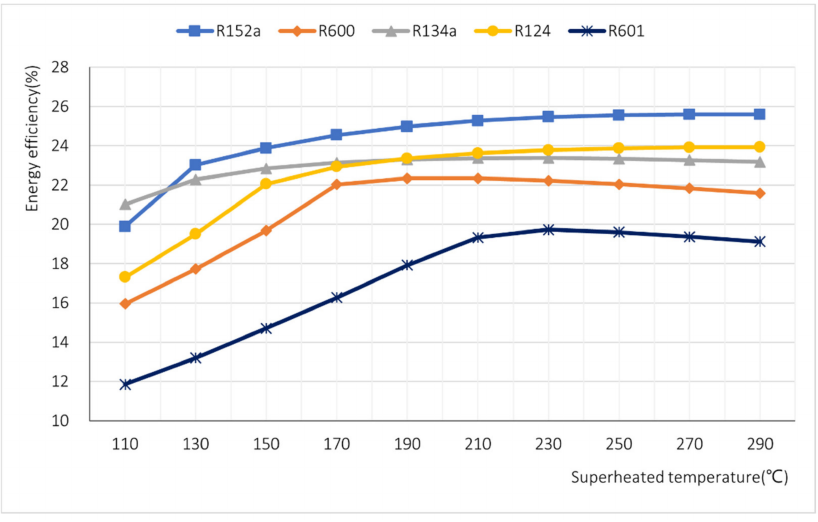
Figure 9. Energy efficiency of the ORC under different working fluids.